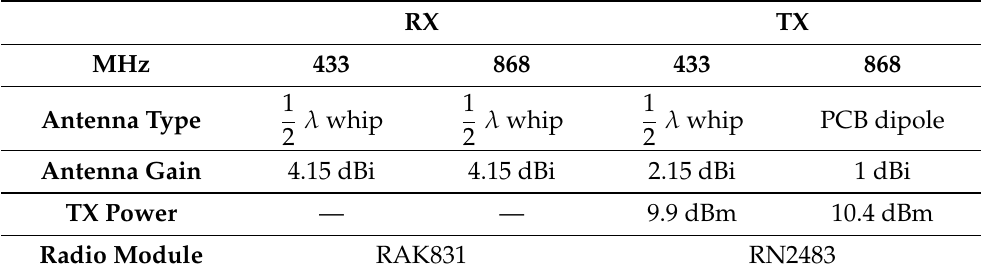
Table 3. System RF Summary.